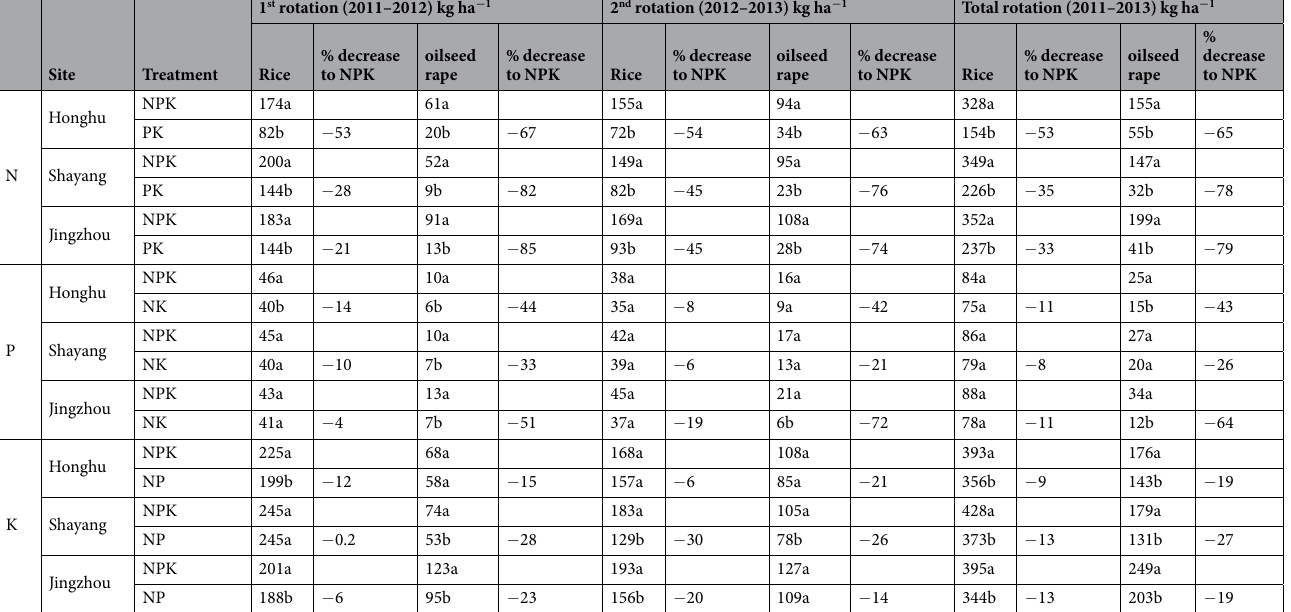
Table 2. Total N, P and K uptake (kg ha − 1 ) by aboveground parts of rice and oilseed rape in different sites of Hubei province affected by with and without NPK fertilization. Mean values within a column for each season followed by different letters are significantly different at P < 0.05 according to